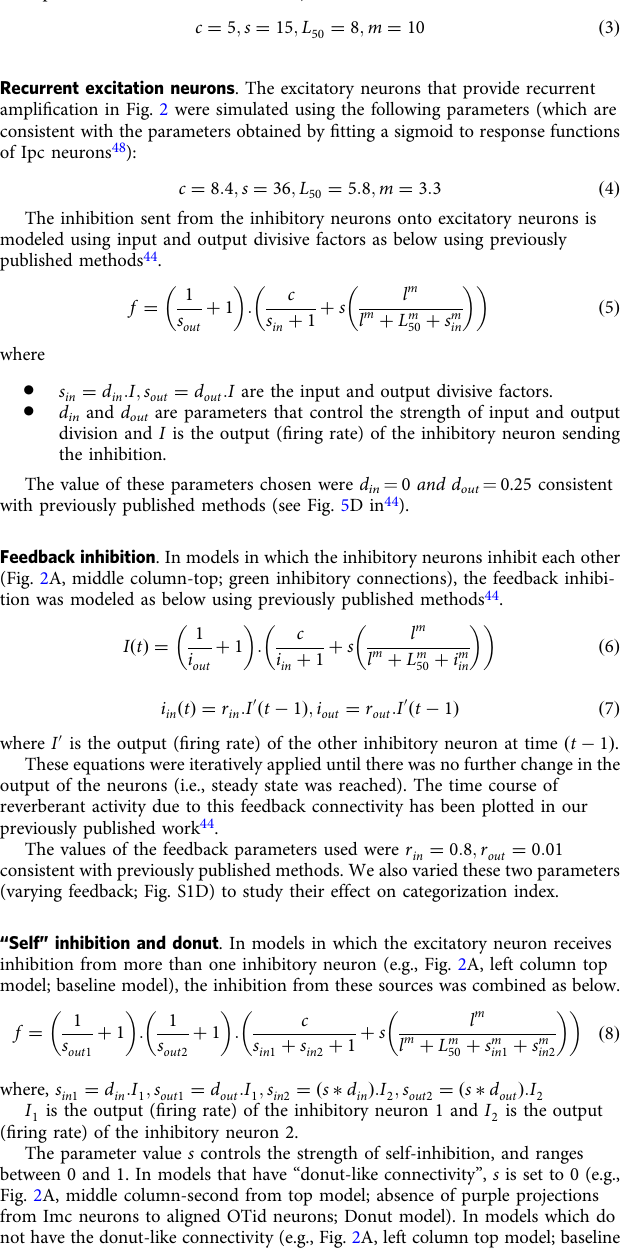
Fig. 2A, middle column-second from top model; absence of purple projections from Imc neurons to aligned OTid neurons; Donut model). In models which